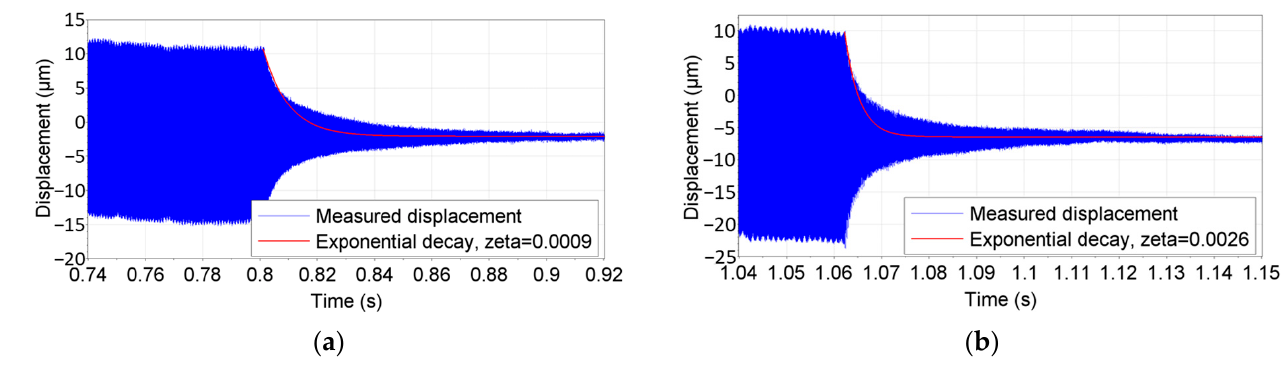
Figure 12. SS 316L D3, UHCF specimen, exponential decay: ( a ) Maximum stress = 204 MPa; ( b ) Maximum stress = 350 MPa.